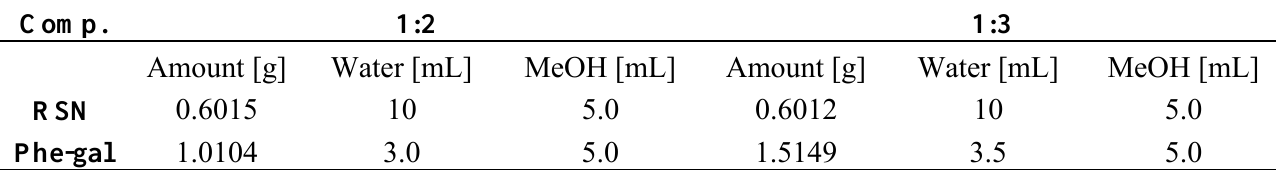
Table 2. Risedronate (RSN) and phenyl- β - D -galactopyranoside (Ph-gal) in ratios 1:2 and 1:3 with addition of methanol (samples 4 - 7